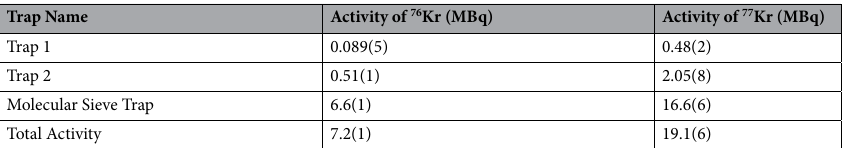
Table 2. Production and the location of online collection results of 76 Kr and 77 Kr*. *All activity was measured after the irradiation at approximately 16 h in relationship to the plots in Figs. 5 and